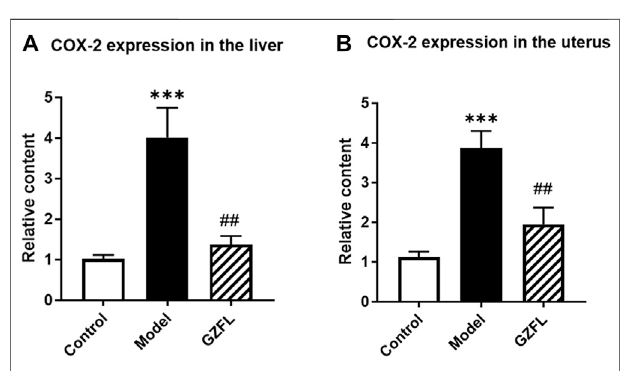
FIGURE 10 | COX-2 gene expression changes in rats (A) COX-2 expression in liver (B) COX-2 expression in uterine tissue (x ± s , n (cid:2) 6, compared with Control group: *** p < 0.001; compared with Model group: ## p < 0.01).